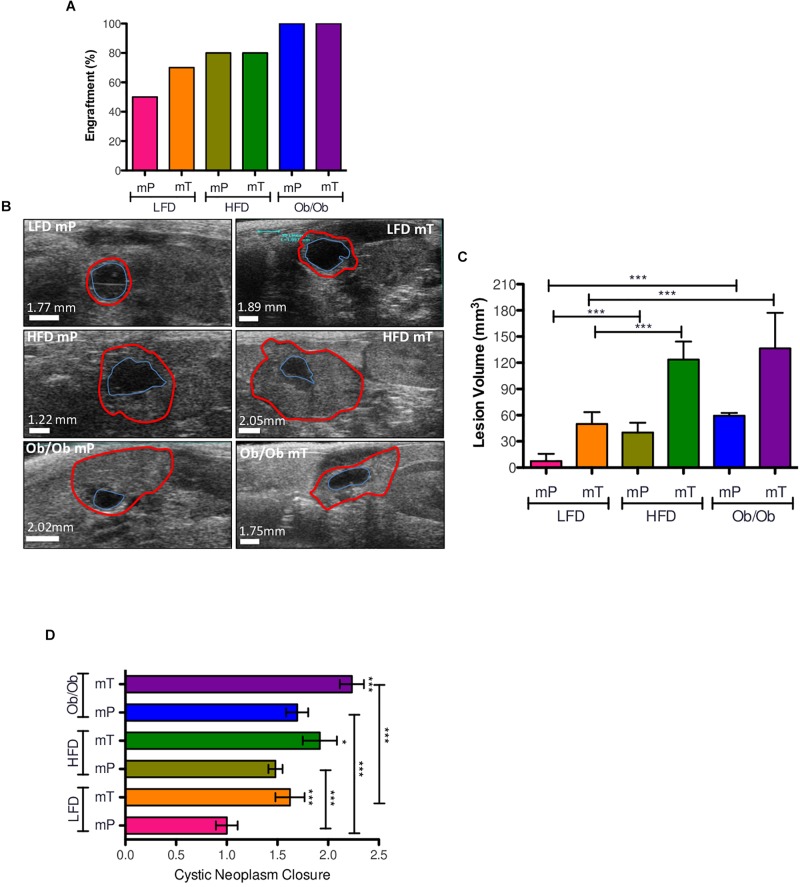
Effect of obesity on organoid-transplant models engraftment and growth. (A) Obesity accelerated the engraftment rate of preinvasive preneoplastic (mP) and neoplastic (mT) organoid models. Engraftment rate was represented as percentage of mice with pancreatic cysts respect to all mice of each group. (B) Ultrasound imaging of pancreatic cysts; the volume was reports as the increase of external epithelium (red line). (C) Volume analysis of pancreatic cysts. Data of each group were reported as mean and 95%CI; (D) cystic neoplasm closure. All the measures were taken with ultrasound technology (VEVO 2100). *, p < 0.05; ***, p < 0.001; by two-tailed unpaired Student’s t-tests. The borders distance of each cyst was measured with ImageJ software; Red line, external epithelium; Blue line, internal epithelium.